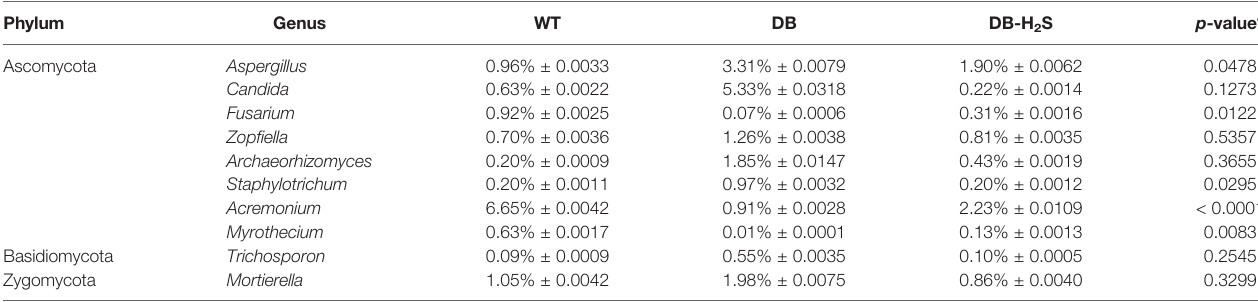
TABLE 2 | The relative abundance of fungal genera that showed an improvement by treatment with exogenous NaHS.